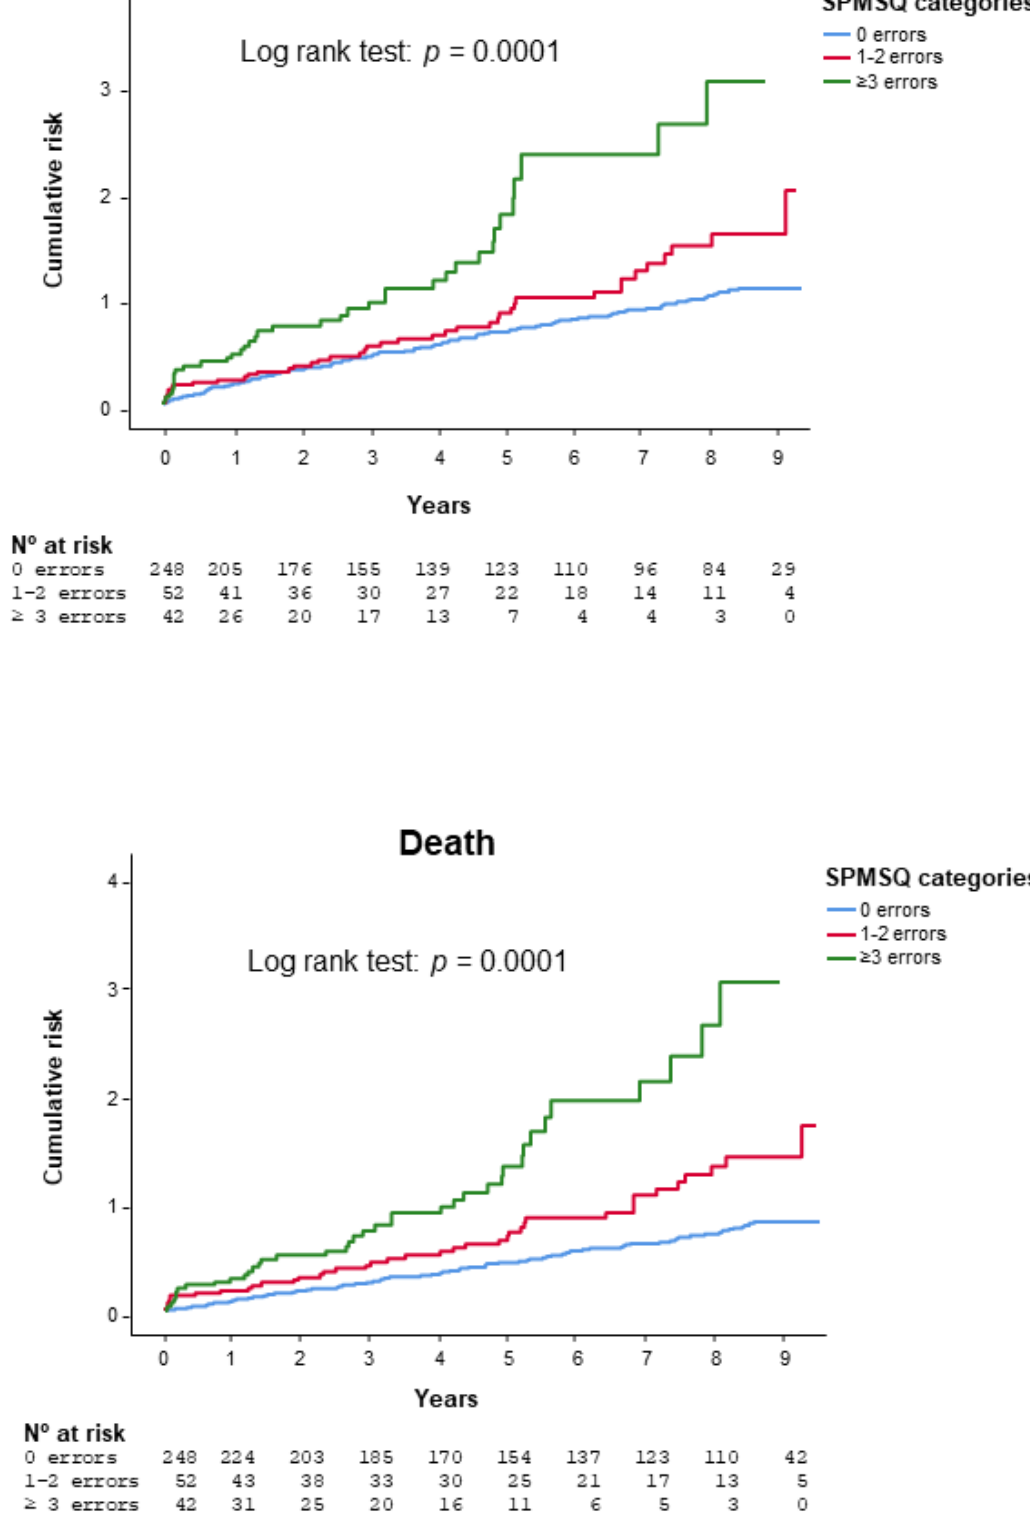
Figure 1. Kaplan–Meier curves comparing SPMSQ categories for death or myocardial infarction ( top ) or death ( bottom ) . Abbreviations: SPMSQ = Short Portable Mental Status